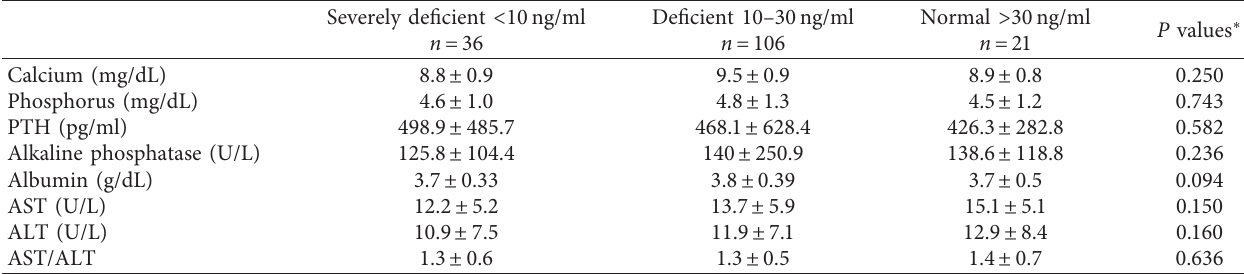
Table 3: Markers of mineral metabolism, liver function, renal function, age, and dialysis period according to serum 25 (OH)D